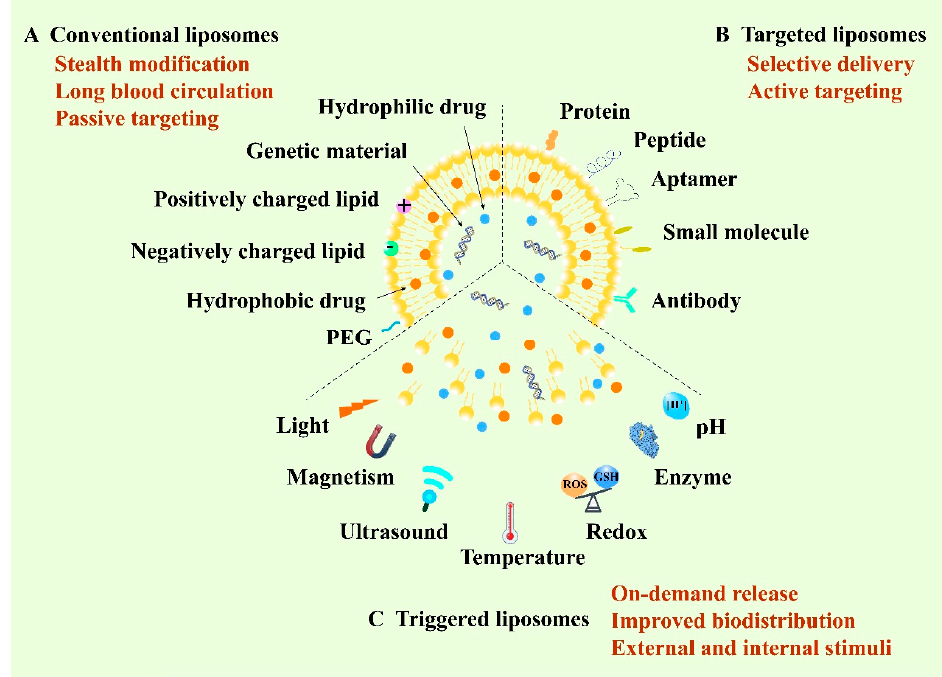
Figure 2. Schematic illustration of various liposome-based delivery systems and their representative properties and typical functions.